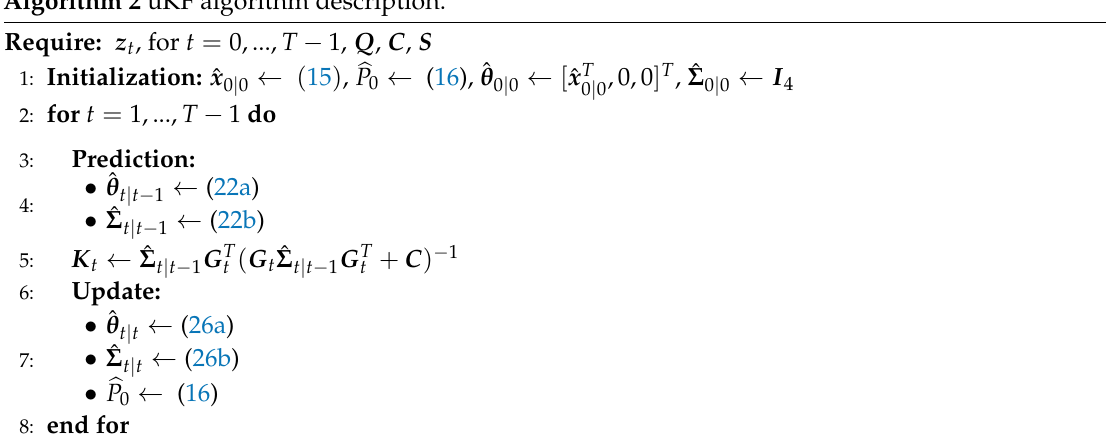
Algorithm 2 uKF algorithm